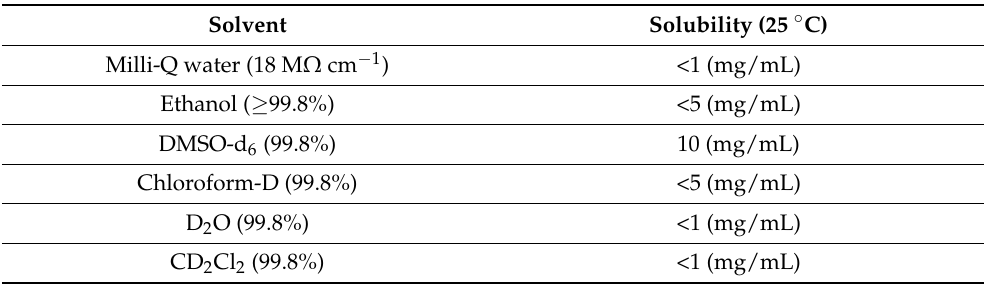
Table A3. Solubility of NSs in inorganic and organic